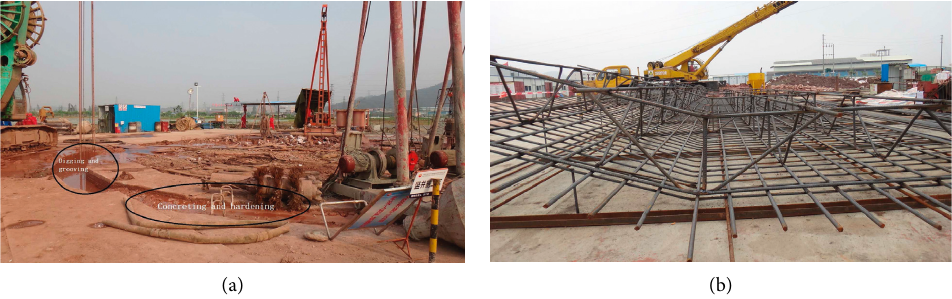
Figure 2: Construction site photos. (a) “ 八 ”shaped trough section and pouring. (b) “ 八 ”shaped section reinforcing